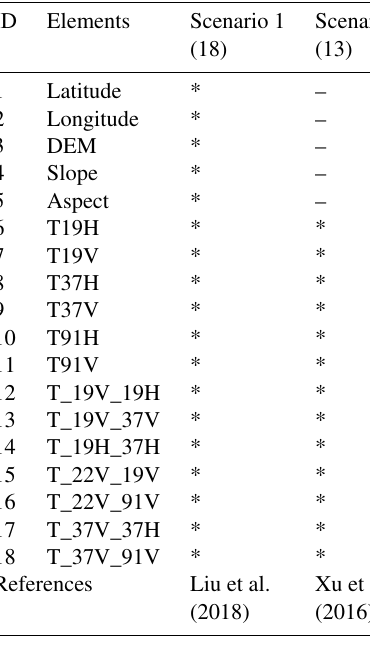
Table 1. The input variables list. The line means this variable is not selected; the asterisk indicates the variable is selected. The numbers in brackets denote the number of variables. T19H is the brightness temperature ( T ) of the 19GHz channel with H polarization. For example, T_19V_19H denotes the difference in brightness temperature between 19V and 19H channel; the others are similarly